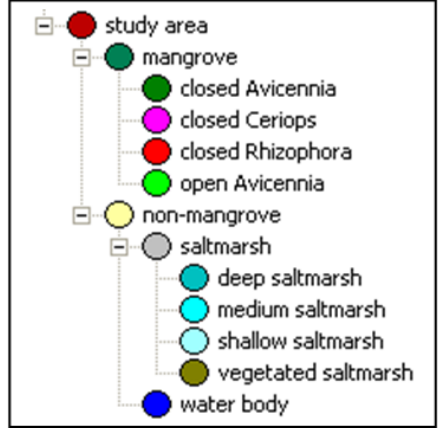
Figure 6. Objects class hierarchy used in this